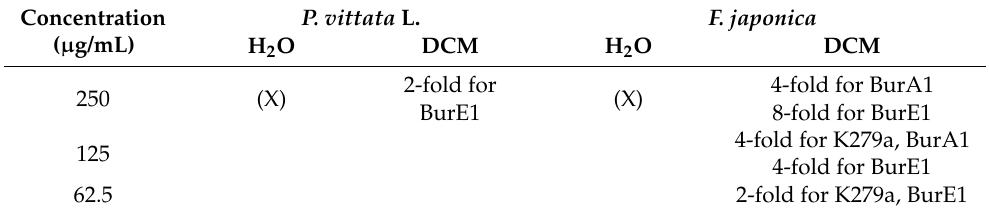
Table 4. Reduction of gentamicin’s MICs in presence of four extracts of P. vittata L. and F. japonica .